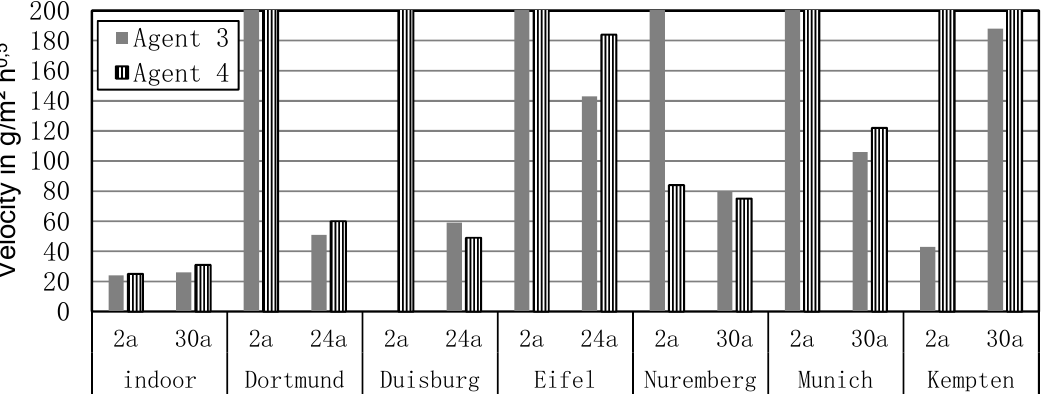
Figure 8. Velocity of water uptake between 5 and 120 min for OKS samples treated with agents 3 and 4 and weathered at the 7 different locations.